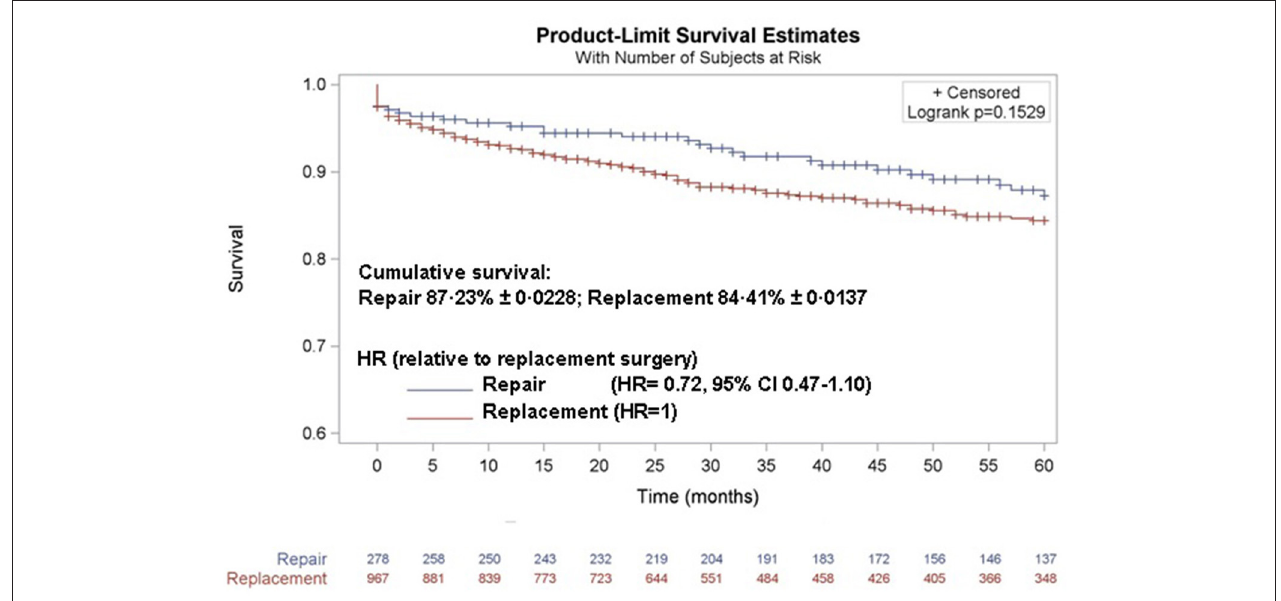
FIGURE 2 | Five-year survival for the MV pediatric population according to surgical type of procedure: replacement with mechanical valve or repair of the damaged